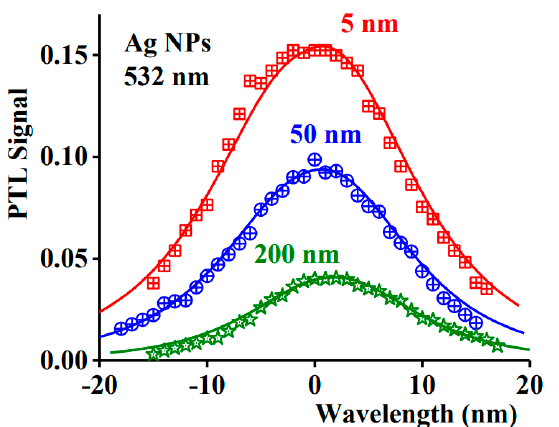
Figure 9. Photothermal lens signal vs. wavelength for various size of NPs (Reproduced from [103] with permission from Elsevier, 2021).